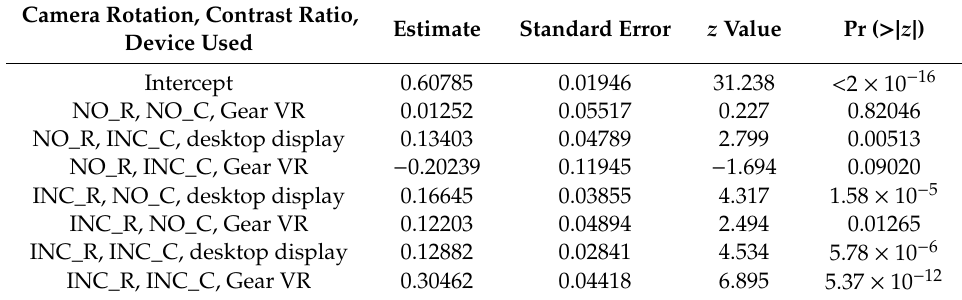
Table 35. Logistic regression analysis results of e ff ects of the variables camera rotation, contrast ratio, and device used.